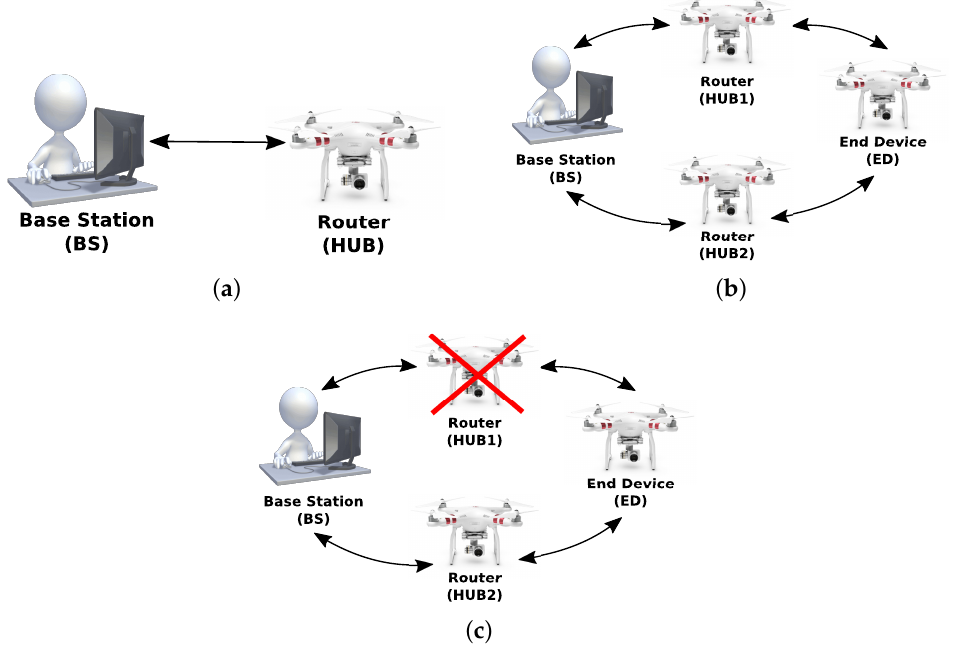
Figure 14. ZigBee devices in configuration scenario 2. ( a ) ZigBee devices in P2P configuration scenario; ( b ) ZigBee devices in a scenario without failure; ( c ) ZigBee devices in a scenario with